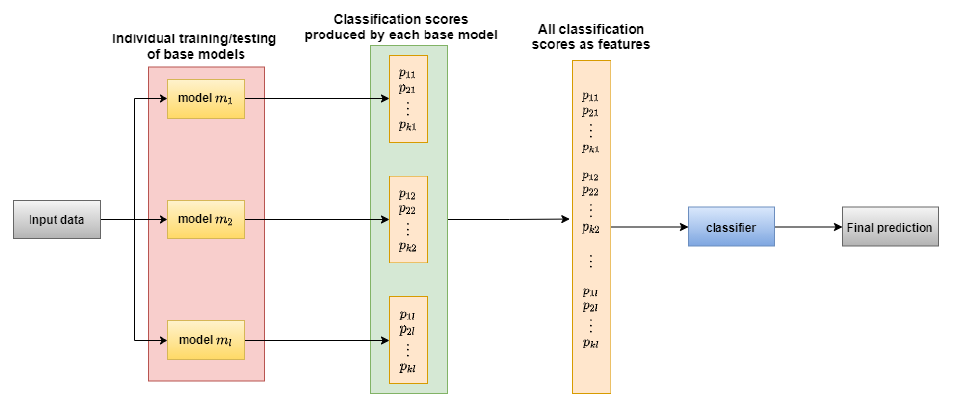
Figure 4. Basic architecture of a trainable ensemble